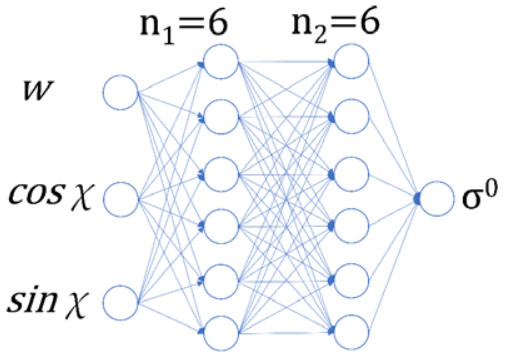
Figure 3. Schematic diagram of BP neural network topology.